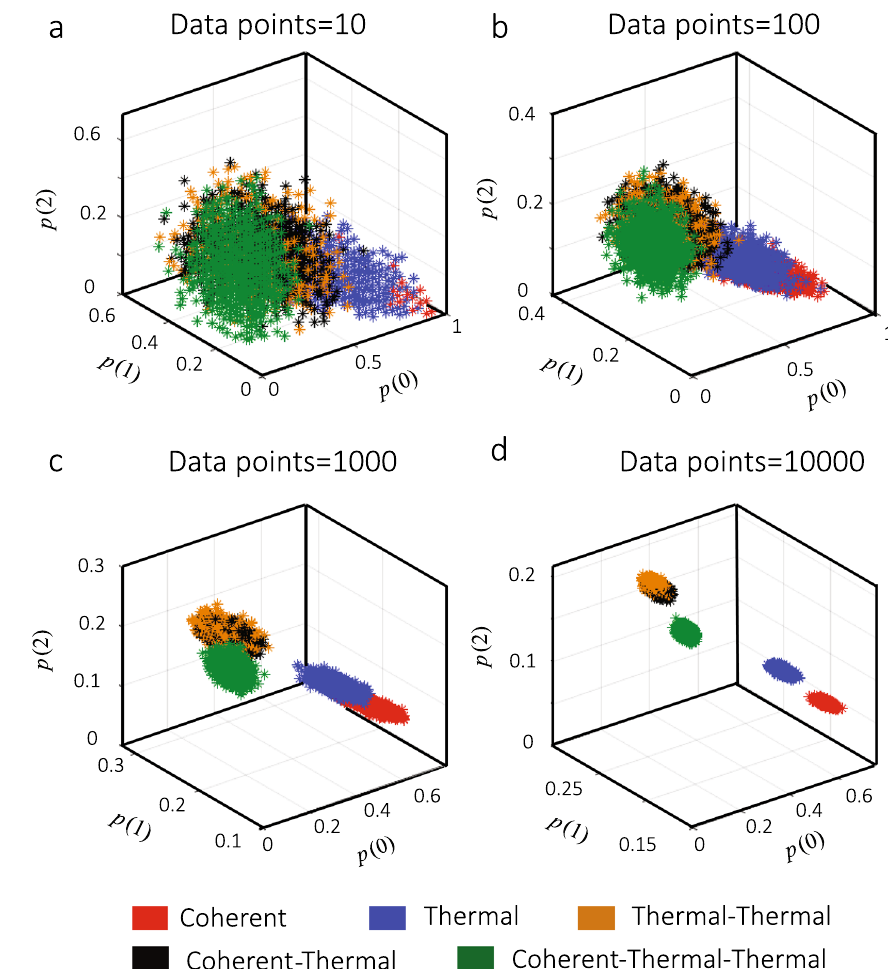
Fig. 3 Projection of the feature space on the plane de fi ned by the probabilities p (0), p (1), and p (2). The red points correspond to the photon statistics for coherent light, and the blue points indicate the photon statistics for thermal light fi elds. Furthermore, the brown dots represent the photon statistics produced by the scattering of two thermal light sources, and the black points show the photon statistics for a mixture of photons emitted by one coherent and one thermal source. The corresponding statistics for a mixture of one coherent and two thermal sources are indicated in green. As shown in a , the distributions associated to the multiple sources obtained for 10 data points are con fi ned to a small region of the feature space. A similar situation prevails in b for 100 data points. As shown in panel c , the distributions produced with 1000 data points occupy different regions, although brown and black points keep closely intertwined. Finally, the separated distributions obtained with 10,000 data points in d enable ef fi cient identi fi cation of light